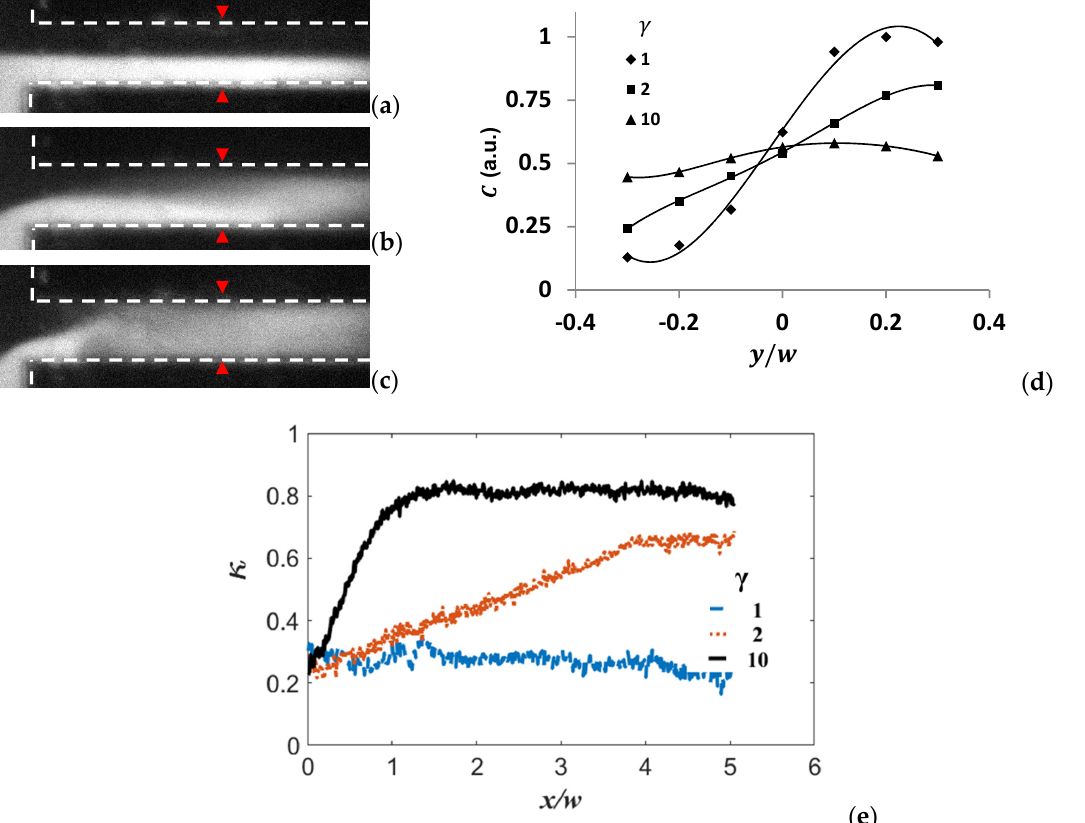
Figure 4. Visualization and comparison of mixing results in the micromixer with different conductivity ratios 𝛾 at 𝐸 (cid:3002) =833 V/cm. ( a ) 𝛾 = 1 , ( b ) 𝛾 = 2 , ( c ) 𝛾 = 10 , and ( d ) comparison of concentration profile in transverse direction at 𝑥 𝑤⁄ = 3 from the channel entrance (marked by red line) with different conductivity. ( e ) Mixing index varying along streamwise direction at different conductivity ratios. Specially, mixing results under the same low 𝛾 = 2 in both conductive sidewalls mi- cromixer and plastic sidewalls micromixer with electrodes located at the ends of the chan- nel were measured and compared, as shown in Figure 5. In this part, the applied electric fields are kept constant, i.e., 𝐸 (cid:3002) = 200 V/cm for the two mixers. For the case of Figure 5c, a periodic electric field was added to the applied static electric field, to enhance mixing, which is 𝐸 (cid:3002) = 1667 V/cm (with 20 V p-p voltage) in amplitude and 𝑓 (cid:3002)(cid:3004) = 10 Hz. Figure 5 clearly shows that, under electric field 𝐸 (cid:3002) = 200 V/cm, obviously stronger mixing has been achieved in the micromixer with conductive sidewalls, as shown in Fig- ure 5d. However, in the micromixer with the nonconductive sidewalls, where the elec- trodes are located at ends of the channel, no obvious mixing enhancement was observed (Figure 5b).